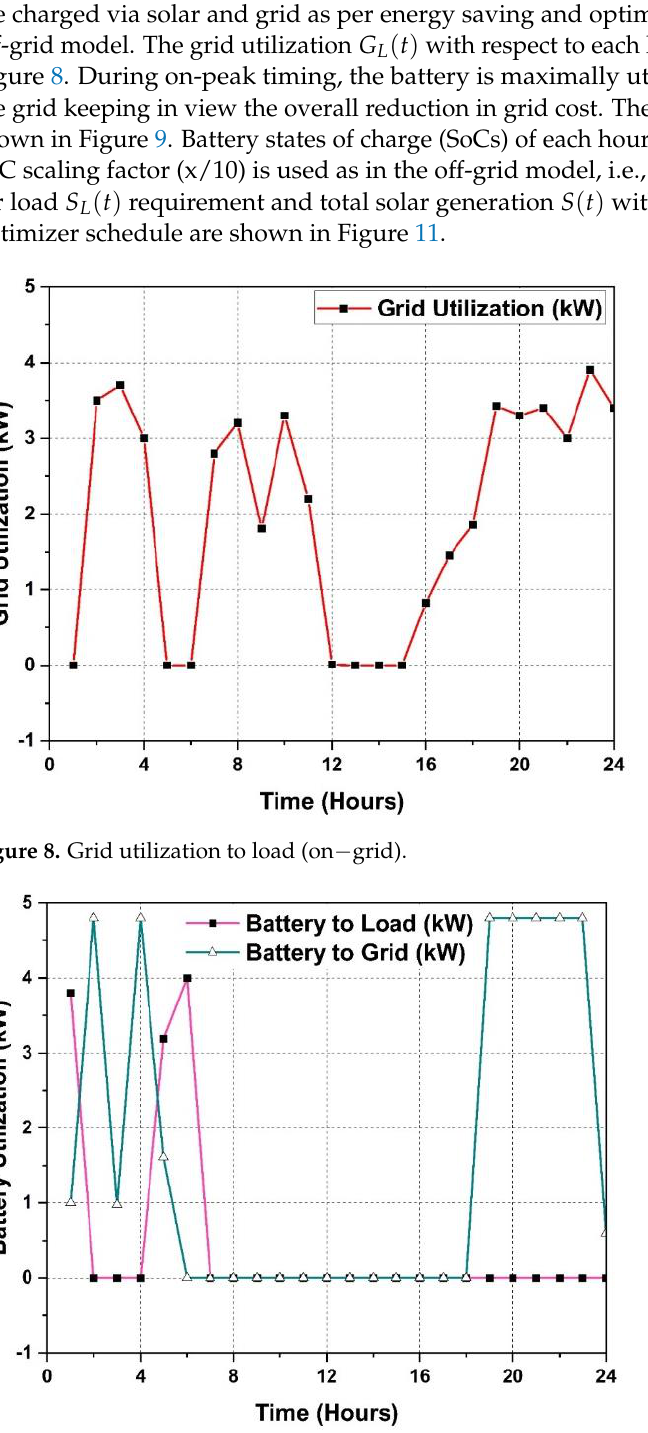
Figure 7. Load demand and resource utilization (off − grid).